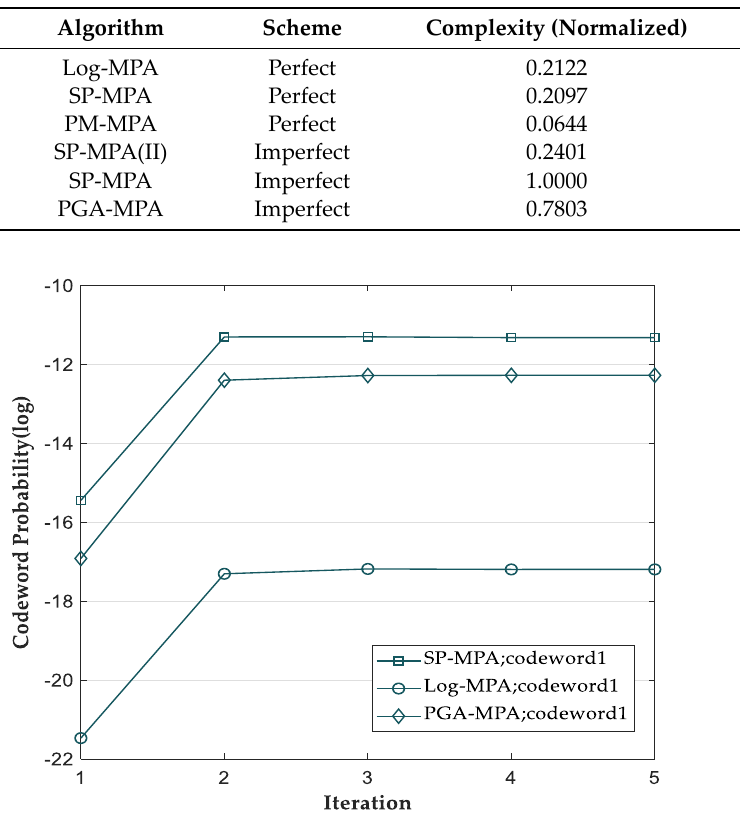
Figure 20. Normalized complexities of different algorithms. Figure 21 shows the bit error rate with groups, which have different delay gaps α in one group. Here, only α is compared, for β has the same impact. It can be seen that smaller α leads to a lower bit error rate because of the smaller interference of delayed symbol. Therefore, users with similar delays have to be grouped in the same collection.